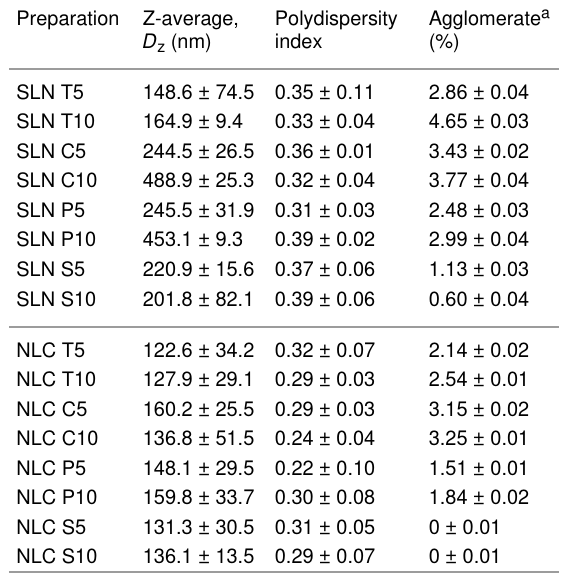
Table 4: Dimensional characteristics of SLNs or NLCs and the pres- ence of agglomerates. Preparation Z-average, D z